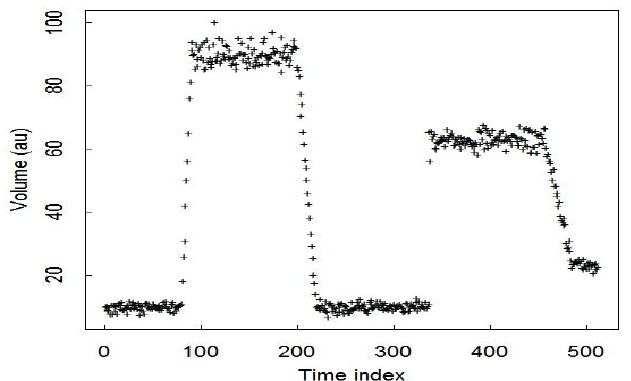
Figure 1. Simulated volume measurements M 512 time